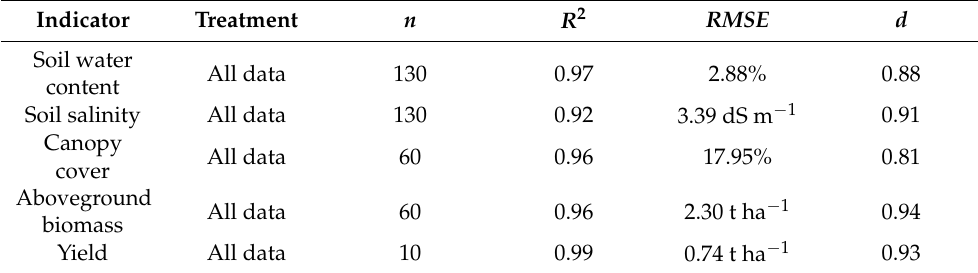
Table 4. Evaluation of the AquaCrop model for simulating soil water content (SWC), soil salinity, canopy cover (CC), aboveground biomass, and yield with the data set in the 2021 cotton season. Indicator